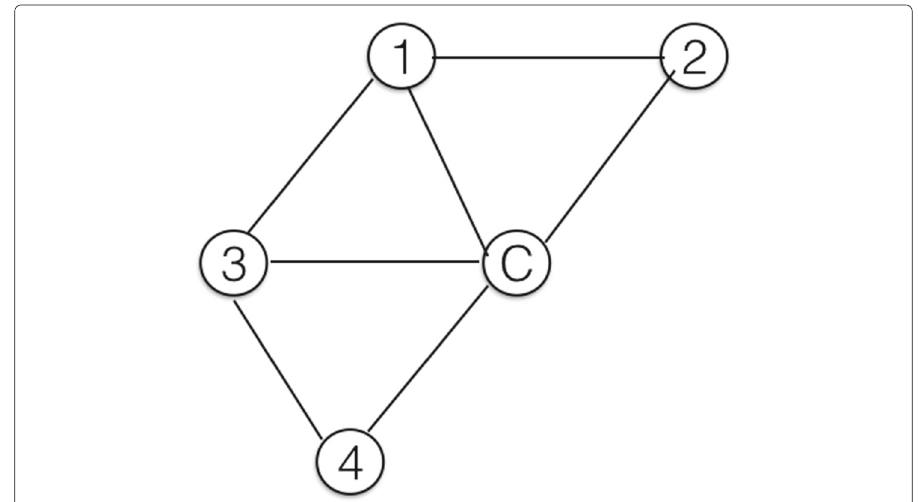
Fig. 10 The corresponding network of information walks in Fig. 9